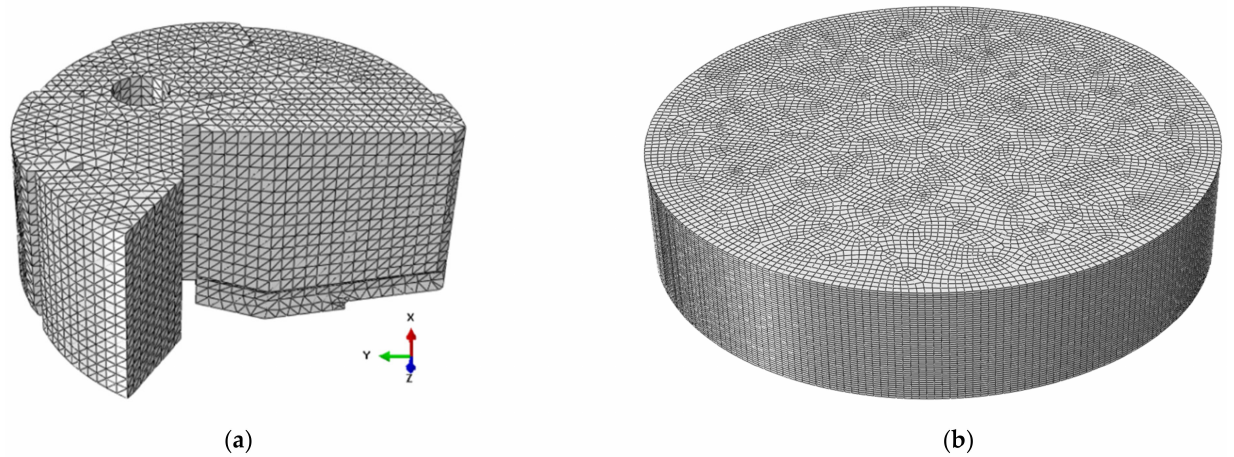
Figure 5. Discretization of the drill head ( a ) and of the workpiece ( b